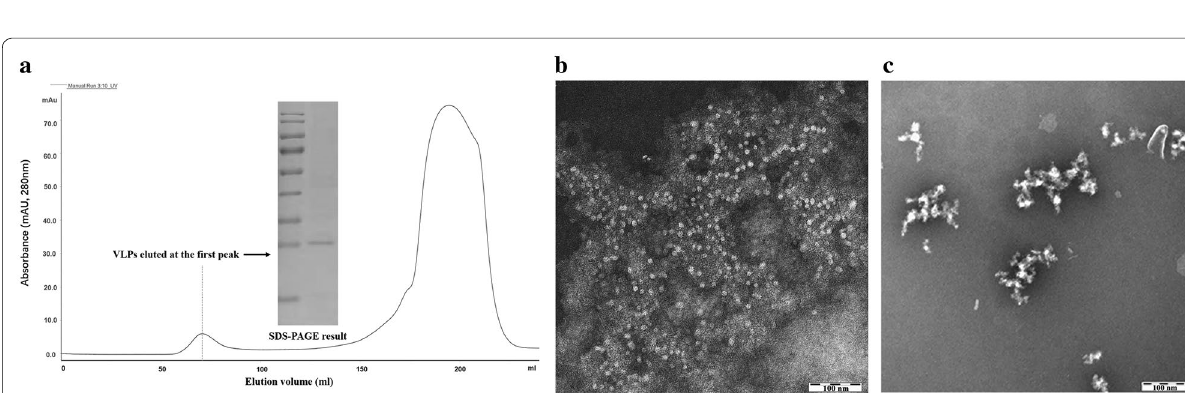
Fig. 4 Characterization of PCV3 VLPs by size‑exclusion chromatography. a Gel filtration profile of PCV3 VLPs. The VLPs were eluted at the first peak and subjected to SDS‑PAGE and b TEM. c TEM images of purified